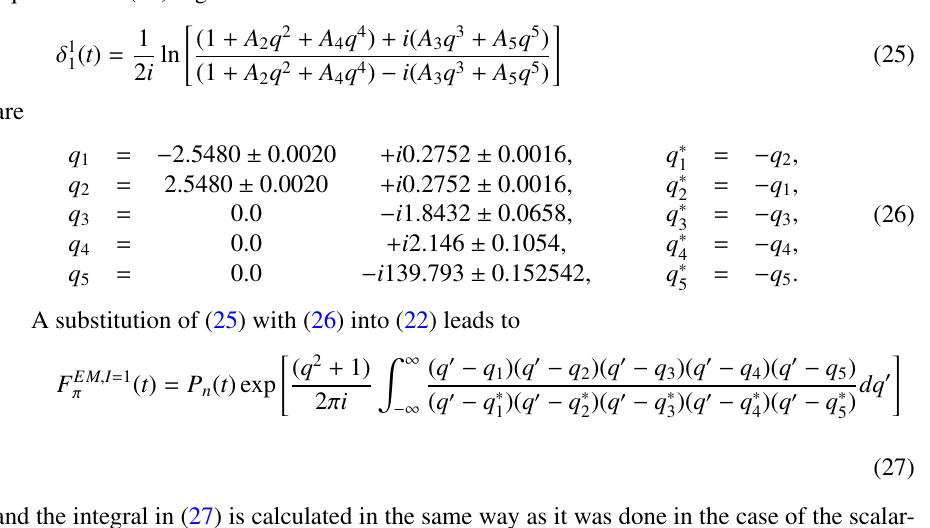
Figure 4. Optimal description of the GKPY δ 1 4 nonzero coe ffi cients A i in